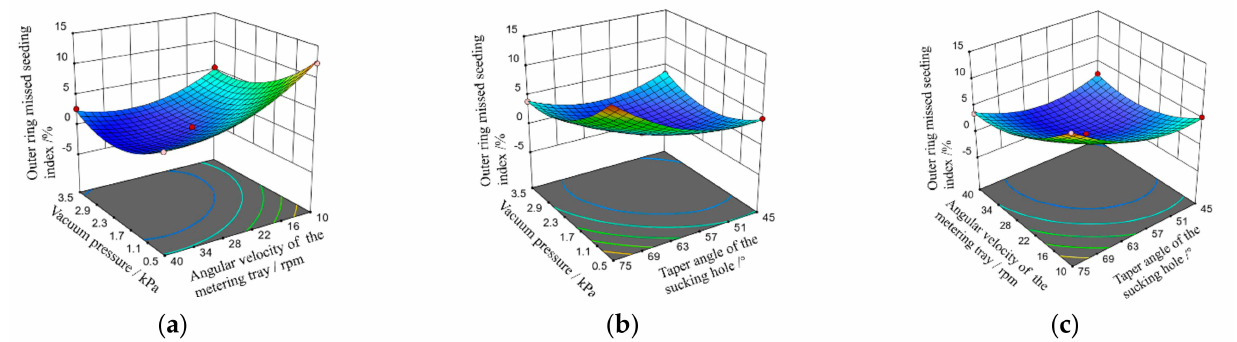
Figure 9. Effect of ( a ) angular velocity of metering tray and vacuum pressure, ( b ) taper angle of sucking hole and vacuum pressure, and ( c ) taper angle of sucking hole and angular velocity of metering tray on the outer ring qualified index.